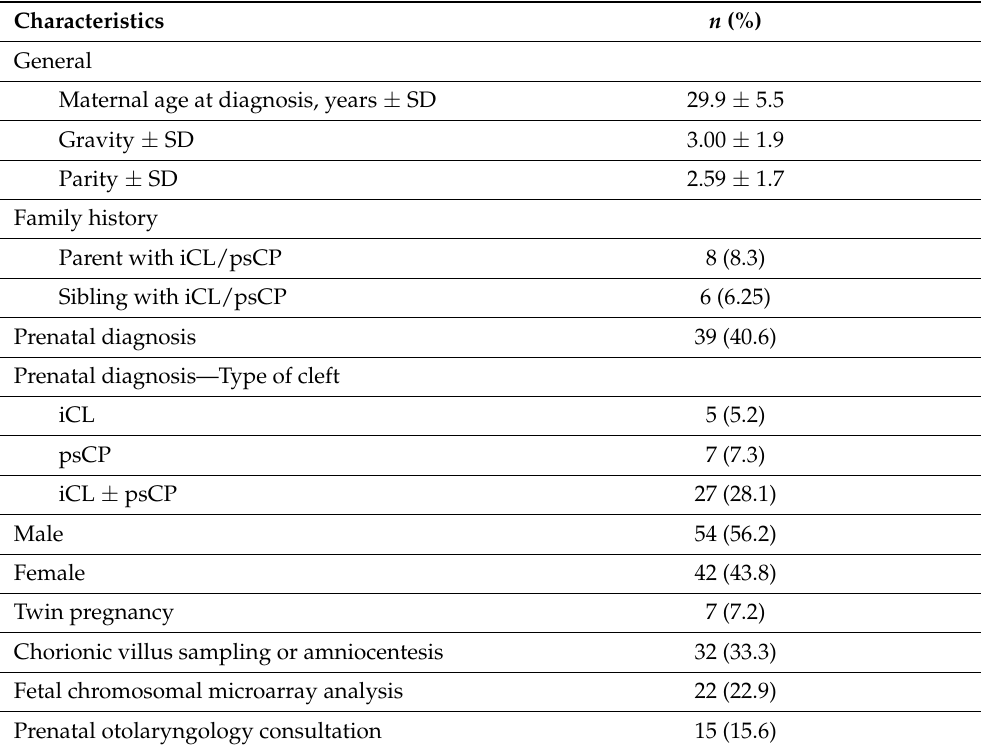
Figure 1. Flow diagram of the study group. Table 1. Clinical characteristics of the study group ( n =